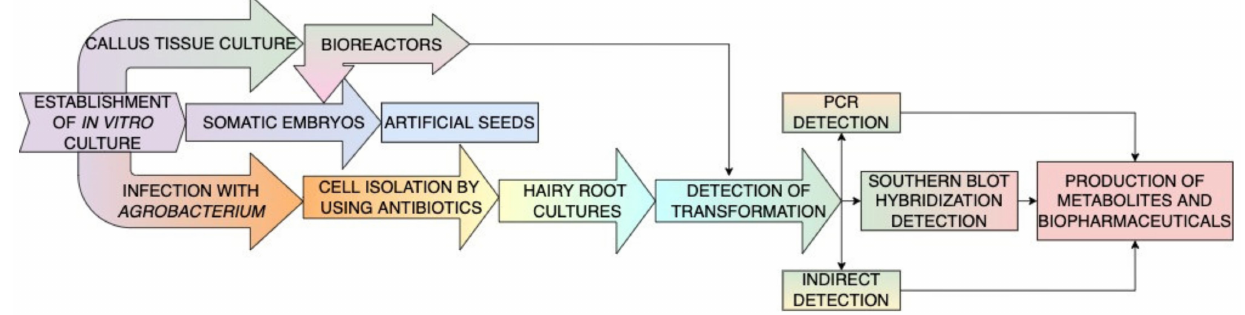
Figure 3. Production of secondary metabolites in plant cultures in